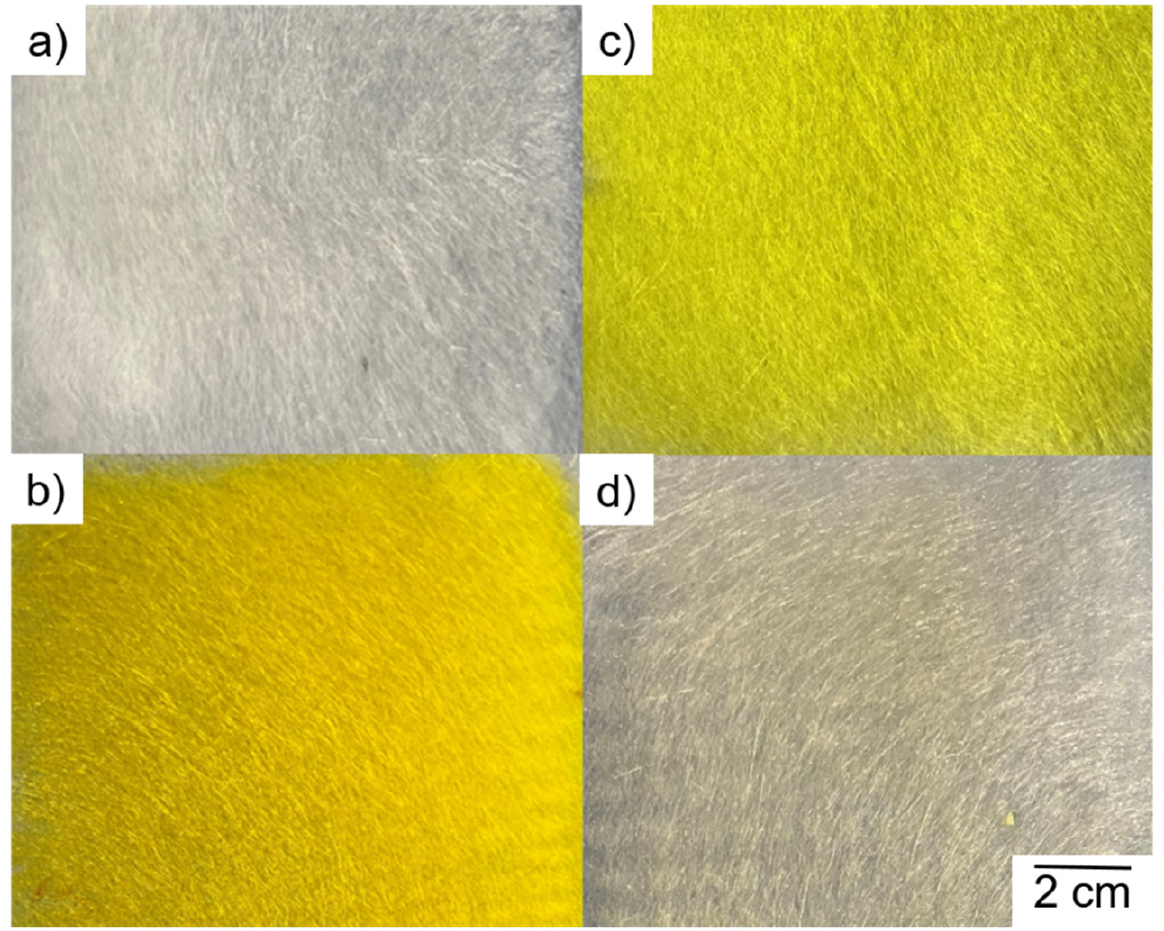
Figure 19. Visual appearance of melt-electrospun fiber webs prepared from ( a ) pure PLA and composites containing 5% ( w / w ) of ( b ) alizarin, ( c ) curcumin, and ( d ) quercetin.